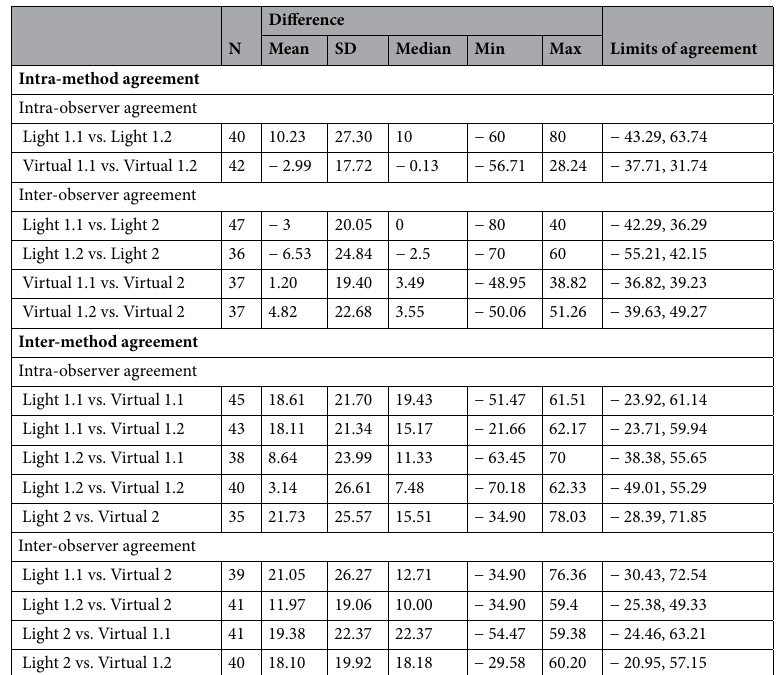
Table 3. Intra- and inter-method, intra- and inter-observer agreement for the percentage of Gleason pattern 4, evaluated on the core level. N sample size; SD standard deviation; Light 1.1, First review by Reviewer 1 on light microscopy; Light 1.2, Second review by Reviewer 1 on light microscopy; Virtual 1.1, First review by Reviewer 1 on virtual microscopy; Virtual 1.2, Second review by Reviewer 1 on virtual microscopy; Light 2, Reviewer 2 on light microscopy; Virtual 2, Reviewer 2 on virtual microscopy.